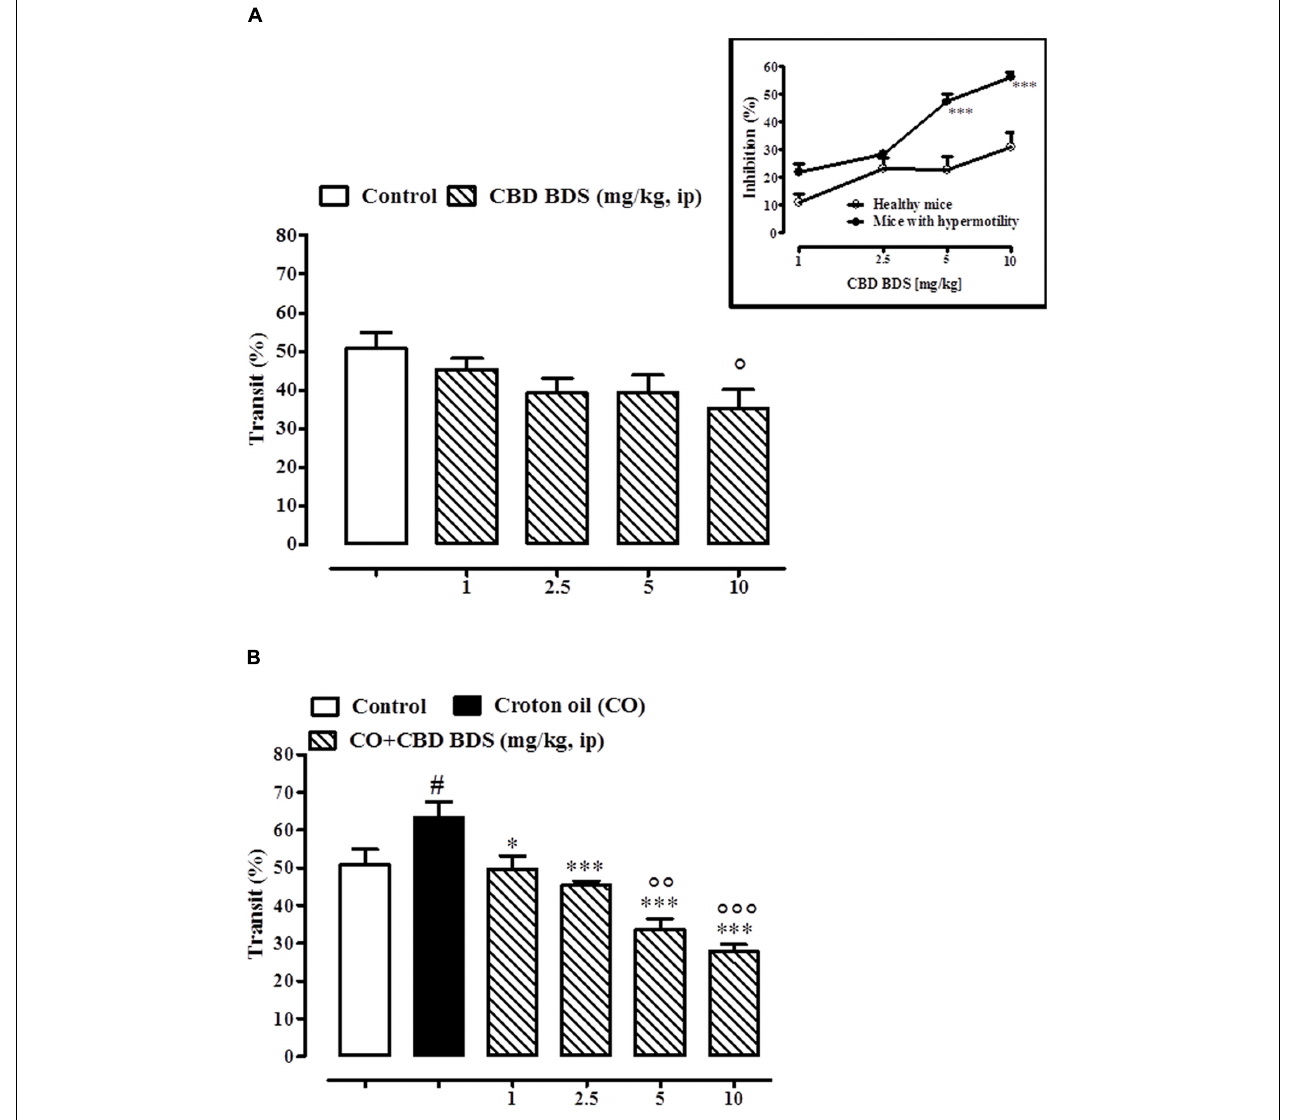
FIGURE 4 | Effect of CBD BDS (1–10 mg/kg, intraperitoneally) on intestinal transit in healthy mice (A) and croton oil-treated mice (B). Bars represent the mean ± SEM of 8–10 animals for each experimental group. ◦ and # p < 0.05, ◦◦ p < 0.01, and ◦◦◦ p < 0.001 vs. control and ∗ p < 0.05 and ∗∗∗ p < 0.001 vs. croton oil alone. Insert: Difference between the curves representing the inhibitory effect of CBD BDS on intestinal transit in healthy mice and mice with hypermotility (mice treated with croton oil). Results are expressed as mean ± SEM of 8–10 mice for each experimental group. ∗∗∗ p < 0.001 vs. healthy